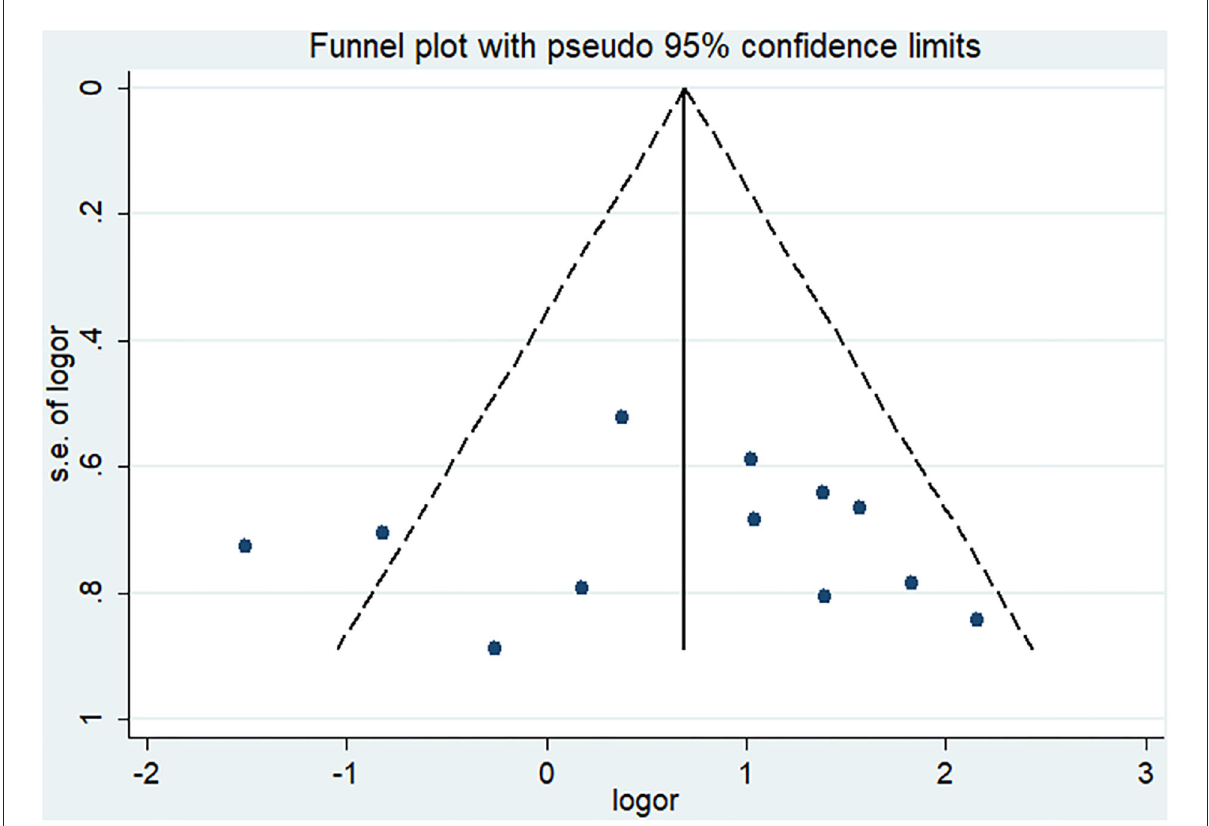
FIGURE4 Funnel plot of overall complications after staged and concurrent cranioplasty and ventriculoperitoneal